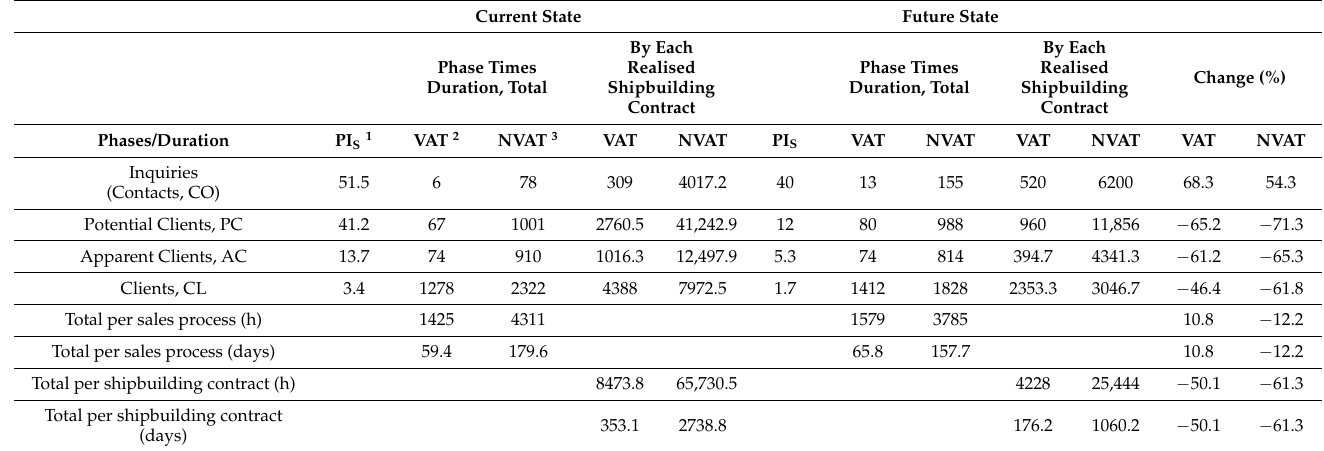
Table 5. Key performance indicator—average sales process duration.